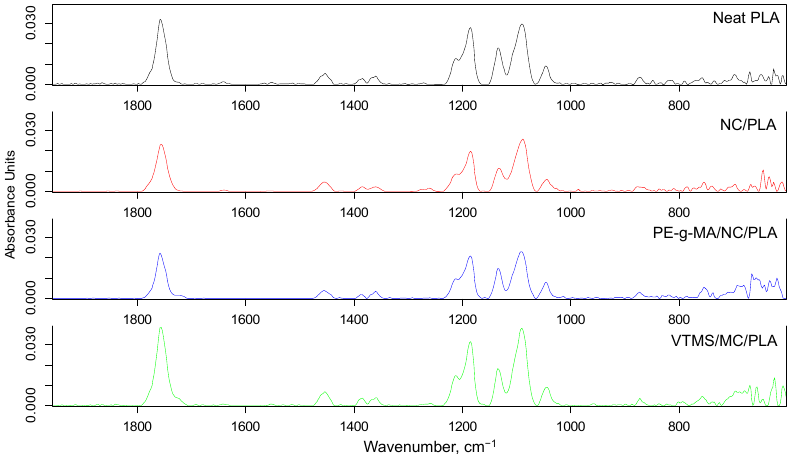
Figure 2. The FTIR spectra of specimens (neat PLA, NC/PLA, PE-g-MA/NC/PLA, VTMS/NC/PLA).